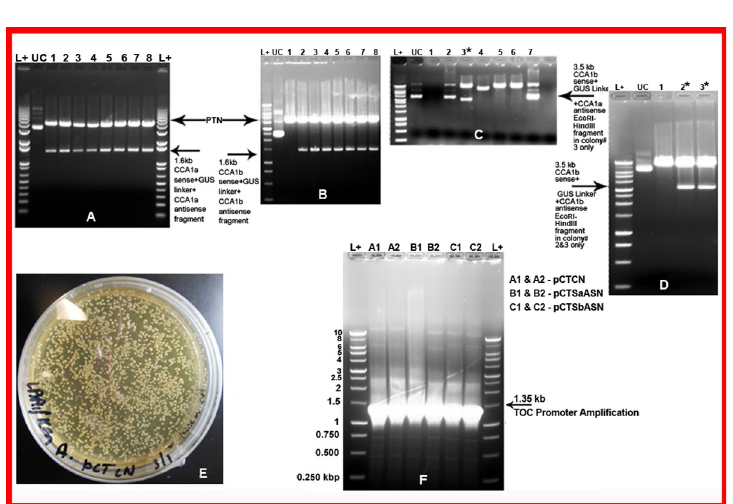
Fig 1. Isolation, cloning of over-expression vector pCTCN and RNAi vectors pCTSaASN and pCTSbASN for repression in pCAMBIA1300. (A) Cloning of CCA1a sense:GUS linker: CCA1a antisense fragments was excised out using BamHI SacI and cloned into pUCTOC1NOS vector by ligating into BamHI SacI site to yield pUCTSaASN vector. (B) CCA1b sense:GUS linker: CCA1b antisense fragments were excised out using BamHI SacI and cloned into pUCTOC1NOS vector by ligating into BamHI SacI site to yield pUCTSbASN vector. (C) The HindIII EcoRI fragment from the pUC19 intermediate vector (pUCTSaASN) having TOC+CCA1a sense GUS linkerCCA1a antisense +NOS was purified and cloned into pCambia1300 vector to give pCTSaASN named as construct B. (D) The HindIII EcoRI fragment from this pUC19 intermediate vector (pUCTSbASN) having TOC+CCA1b sense GUS linkerCCA1b antisense +NOS was purified and cloned into pCambia1300 vector to give pCTSbASN named as construct C. (E) The three constructs A, B and C were then mobilized into chemically competent Agrobacterium tumefaciens strains EHA105 cells and single colonies were obtained on LB + 25 mgl -1 Rif + 50 mgl -1 Kan designated as pCTCN for Construct A. (F) PCR amplification and confirmation of 1.35 kb TOC1 band from randomly selected colonies A1, A2, B1, B2, C1 and C2 RNAi constructs from each of the three plates having constructs A, B and C mobilized in Agrobacterium tumefaciens